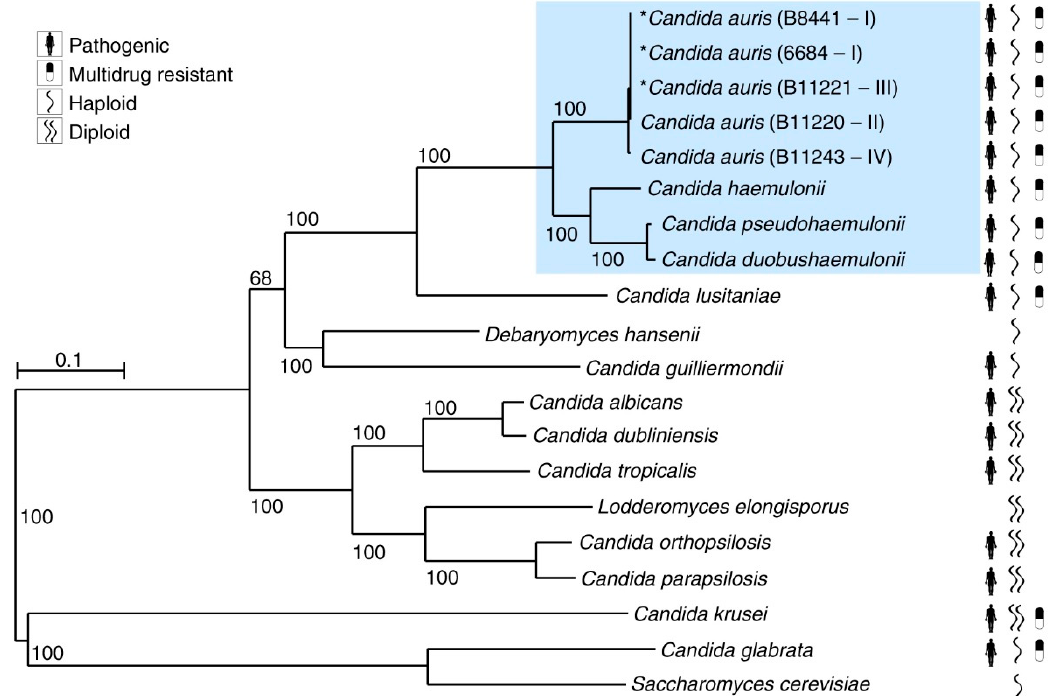
Figure 1. Phylogenetic tree of Candida species studied in the current review, i.e., C. glabrata , C. parapsilosis , C. tropicalis , and C. auris (highlighted in blue). This tree was constructed using maximum likelihood of 11,570 core genes based on 1000 replicates. Asterikes does not serve any specific defnitions. This figure was adopted permission from Munoz et al., 2018 [20].